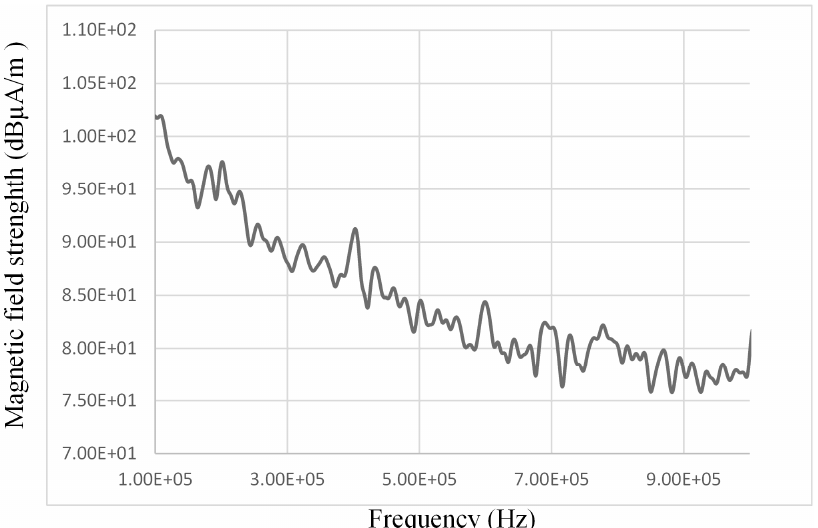
Figure 7. Radiated emission spectrum when the signal generator and the power supply were switched on but the WPT system was switched off. The radiated emissions measurement results when a periodic SFM (with different f m , ∆ f peak and modulation waveforms) and multi-frequency technique (with different f m and ∆ f ) were used are presented in Figures 8–12, Tables 2 and 3. In addition, the efficiency measurement results are shown in Figures 13–15 and Table